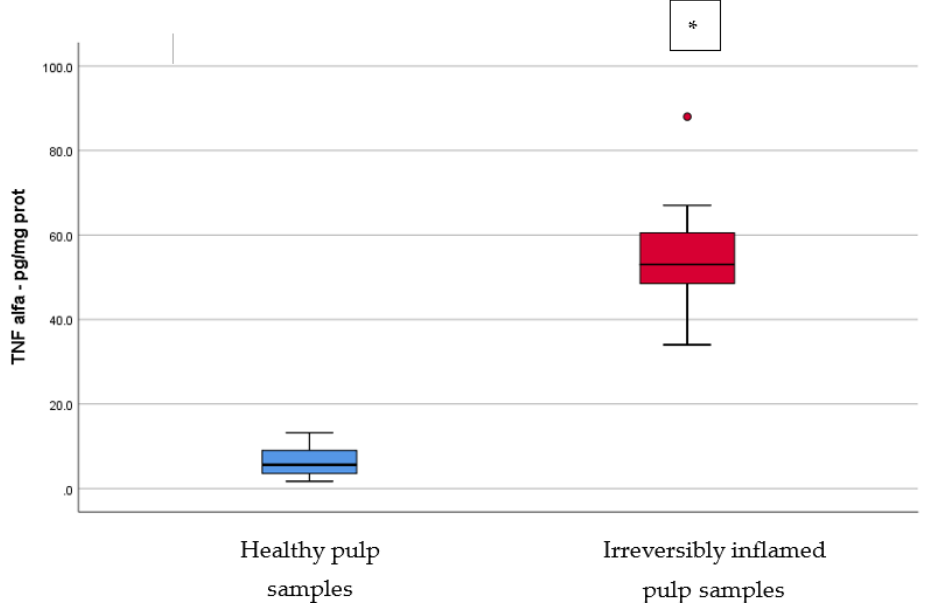
Figure 3. Comparison of TNF- α levels (pg/mg protein) in healthy and irreversibly inflamed dental pulp samples, respectively. The distribution of variables is parametric in both groups according to the Shapiro – Wilk test ( p > 0.05). Welch’s t -test shows that the differences between the two groups are statistically significant ( p < 0.001). (* indicates a statistically significant difference).